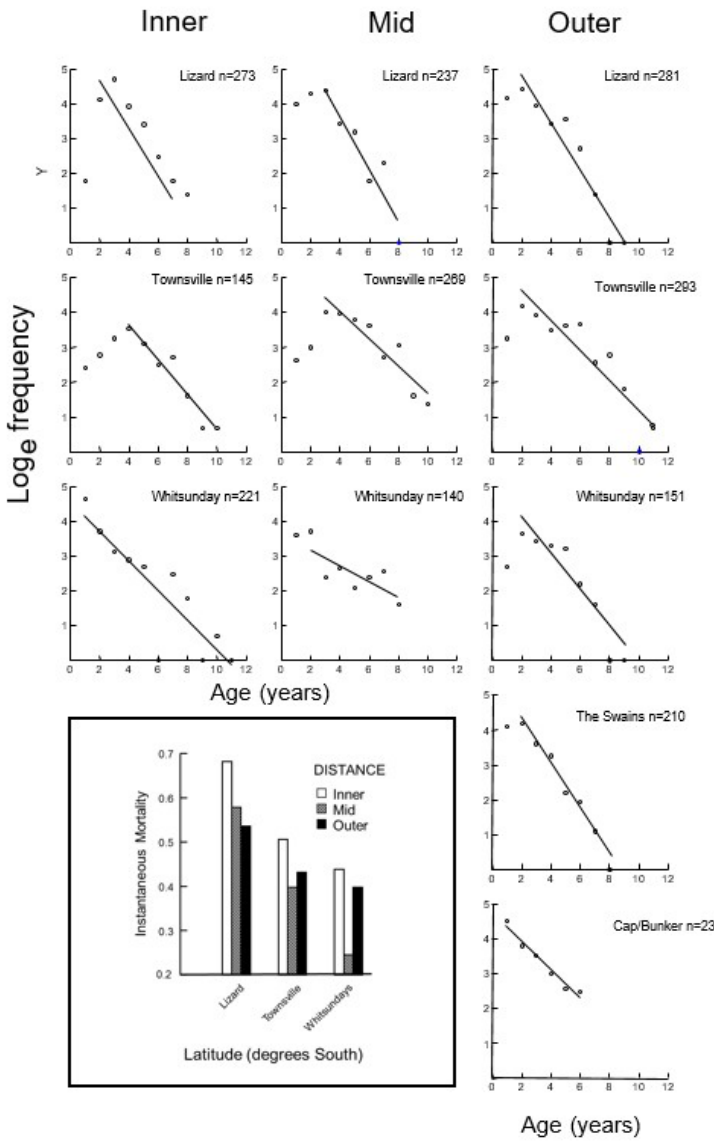
Figure 7. Age-based instantaneous mortality rates for A. polyacanthus collected with distance across the shelf and with latitude (reefs pooled within distances and latitude). The lower left panel presents instantaneous mortality by distance for each of the three latitudes sampled in this orthogonal combination.